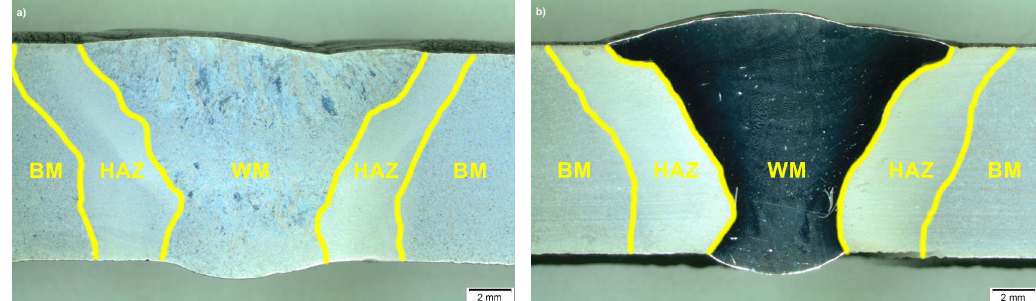
Figure 5. Macroscopic image of test joints: ( a ) joint No. 1; ( b ) joint No. 2; where: WM-weld; HAZ—heat affected zone; BM—basic material.